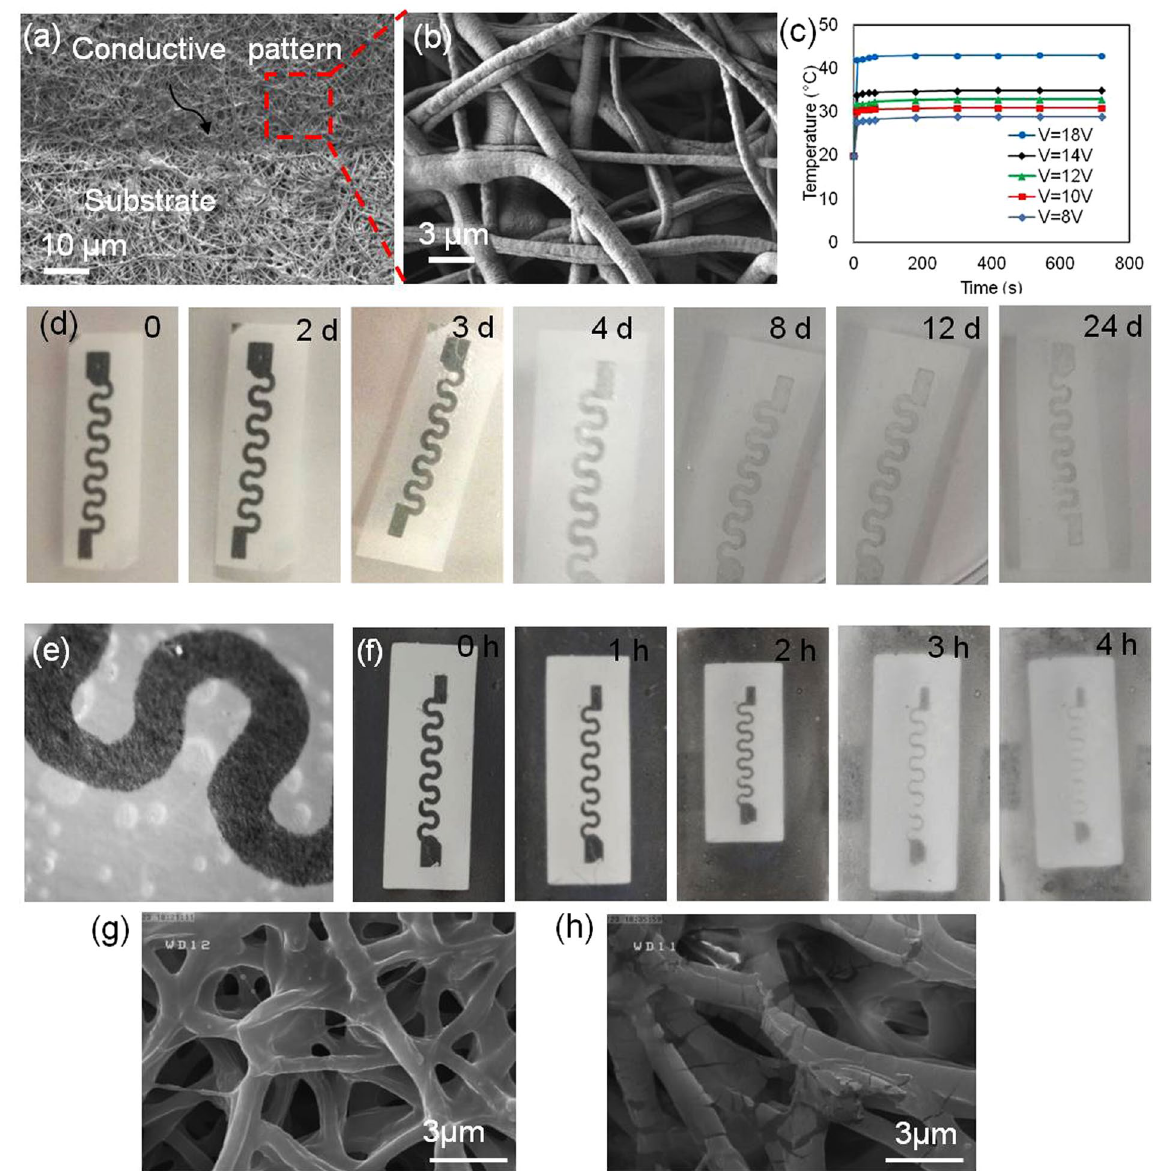
Figure 3. Characterization of the nanofibrous substrate containing nanocarriers and the engineered heater. ( a , b ) Representative images of a nanofibrous substrate with a biodegradable Zn heater deposited by RF sputtering. ( c ) Characterization of the zinc microheater, the resulting temperature as a function of applied voltage. ( d ) Degradation of zinc patterns over 24 days in aqueous solutions containing NaOH (2.5 mM). ( e ) Micrograph showing the hydrolysis of zinc patterns over 24 days. ( f ) Degradation of magnesium patterns over 4 h in aqueous solutions containing 2.5 mM NaOH. ( g ) A representative SEM image of a nanofibrous substrate heated to 38 °C for 1 h confirming the stability of the membranes at that temperature. ( h ) A representative SEM image of nanofibrous substrate heated to 50 °C for 1 h, showing melted, decomposed and deformed